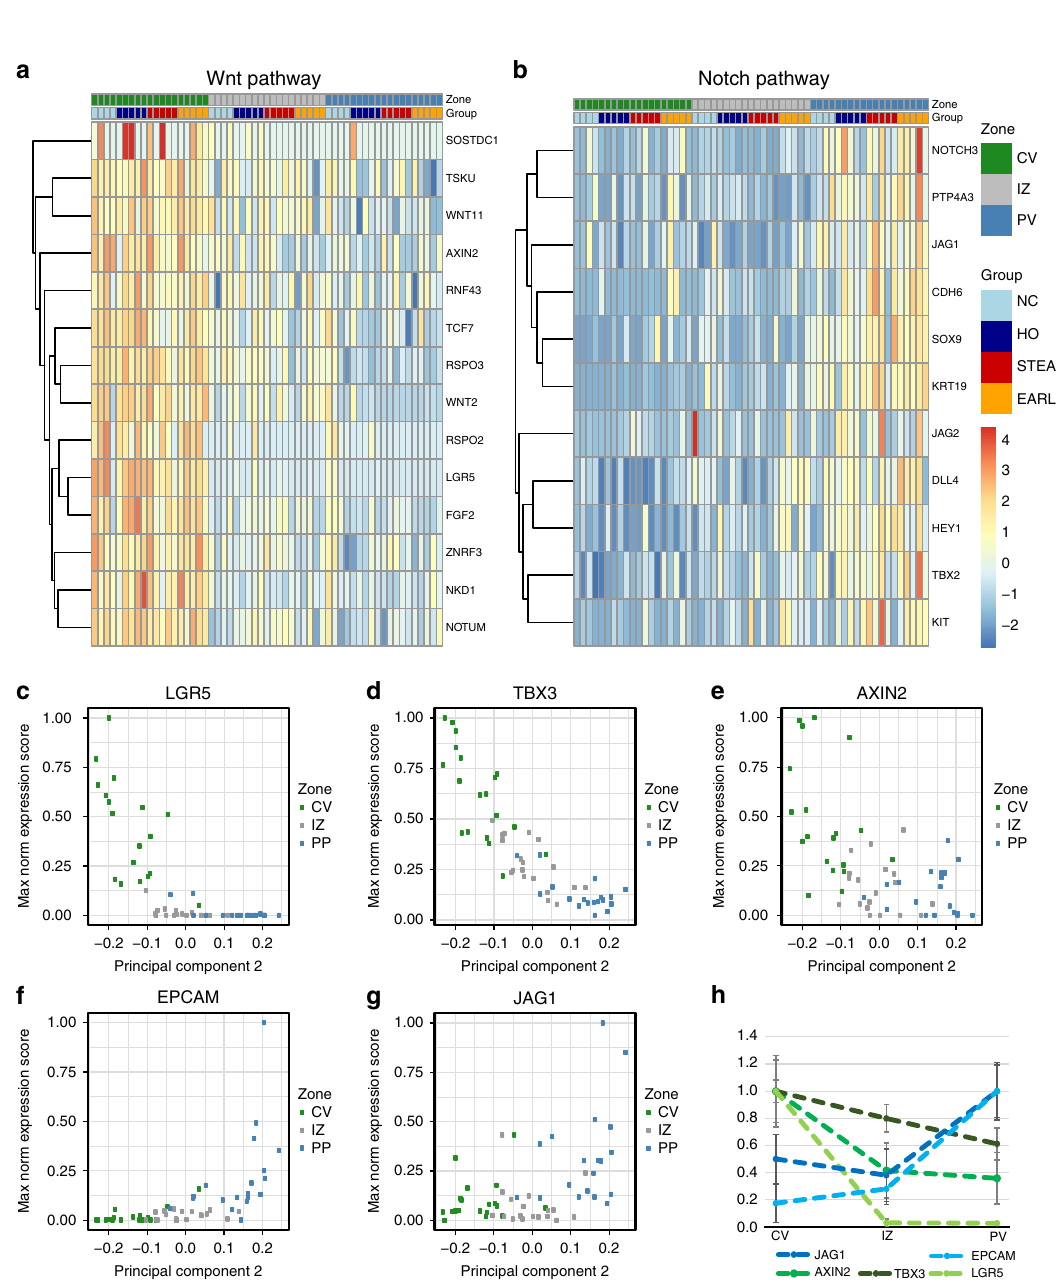
Fig. 4 Morphogen gradients and regulatory networks along the porto-central axis. a Expression z -scores of Wnt signalling pathway genes (GO:0016055, GO:0090263, GO:0030178) show a gene-speci fi c zonation signature. b Expression z -scores of Notch signalling pathway genes GO:0007219. c – g Zonation pro fi le of transcripts for morphogens LGR5 , AXIN2 , TBX3 , EPCAM and JAG1 . The x -axis is the principal component 2, as a measure for zonation (Note, for visualization reason the PCA2 axis was inverted). h Direct normalized gene expression (including standard deviation) of the morphogens depicted in c – g dissected from the pericentral, intermediate and periportal zones. Dashed lines are for visualization only